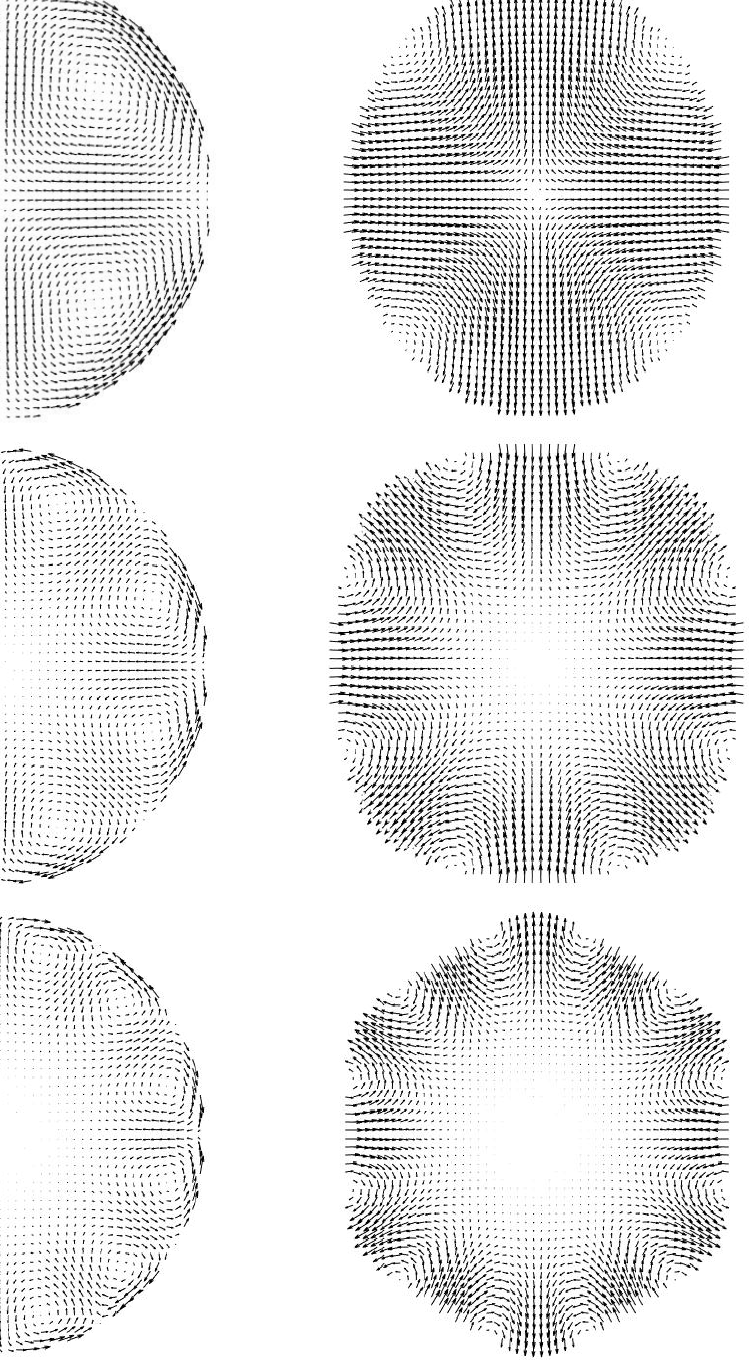
Figure 2. Electric field displacement in a disk as prescribed by (12) for f = J k and k = 2,4,6. Boundary conditions may be of Dirichlet type ( left ) or Neumann type ( right ). The shapes on the right-hand side do not seem to be defined on circles, however this is just an optical